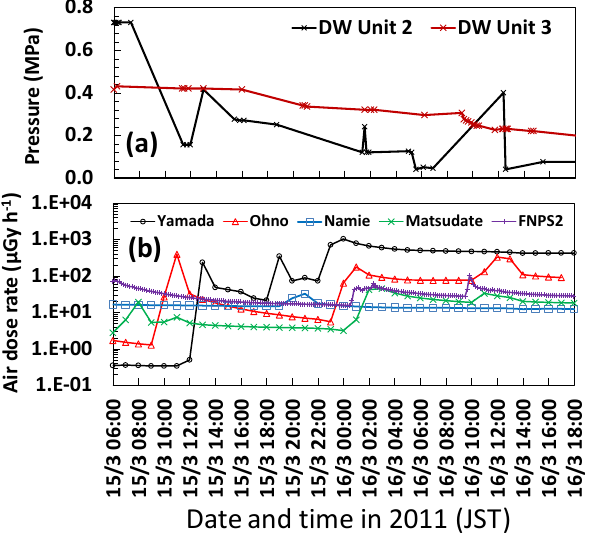
Figure 8. Temporal changes in measurements of (a) the pressure of the reactor pressure vessel (RPV) at Unit 2 of FNPS1, and (b) the air dose rates and total 131 I concentration at several monitoring posts and JAEA-Tokai, respectively, from 14 to 15 March. The locations of the monitoring posts are depicted in Fig. 2.